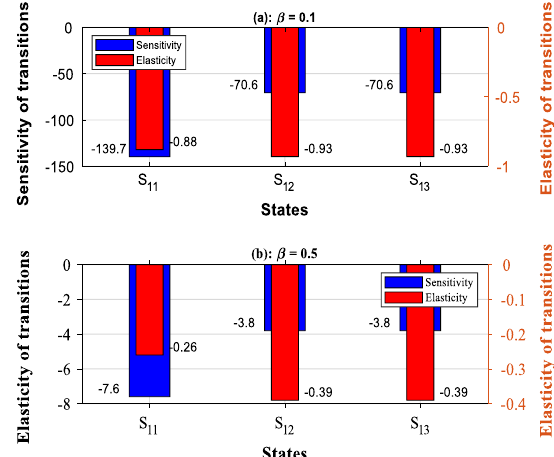
Fig.16 Mean system state transitions with imperfect repairs – 60% diagnostic coverage